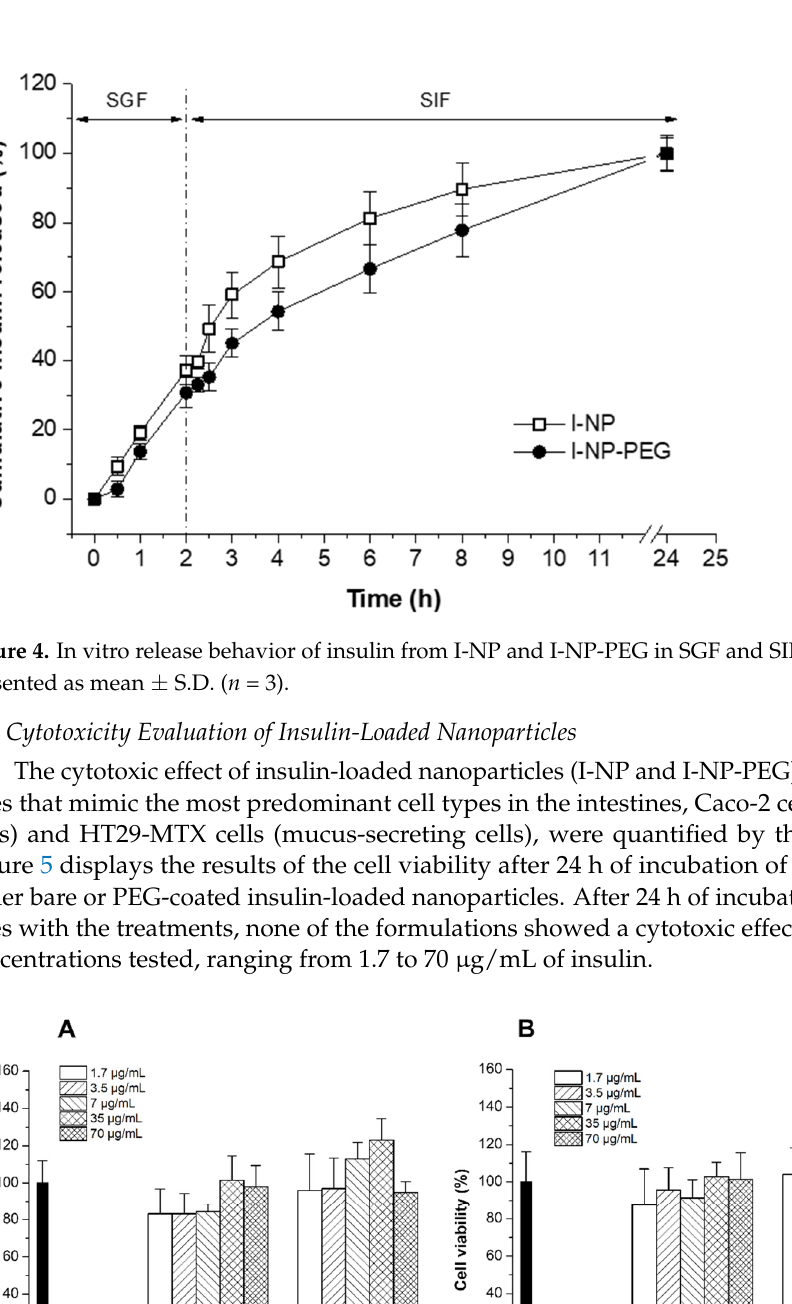
Figure 6. Effect over the fat storage of C. elegans cultured under high-glucose conditions of empty and insulin-loaded zein nanoparticles (coated with PEG and uncoated), as well as a solution of free insulin. Data presented as mean ± S.D. ( n ≥ 75 worms). * p < 0.05; ** p < 0.01. Orl: Orlistat; Ins: free insulin; NP: empty bare zein nanoparticles; I-NP: insulin-loaded bare nanoparticles; NP-PEG: empty PEG-coated nanoparticles; I-NP-PEG: insulin-loaded PEG-coated nanoparticles. Regarding the effect of nanoparticles, the first step was to confirm if the worms ate the nanoparticles. As presented in Figure 7, the fluorescence caused by the presence of lumogen red in nanoparticles (incorporated in the medium in which the worms were grown) is observed all along the gastrointestinal tract of the animal. For I-NP-treated worms, the amount of fat accumulated in these animals was calculated to be about 30% lower than for control worms (NGM group in Figure 6). In a similar way, animals treated with I-NP-PEG displayed a reduction in their fat content close to 40%; slightly lower than